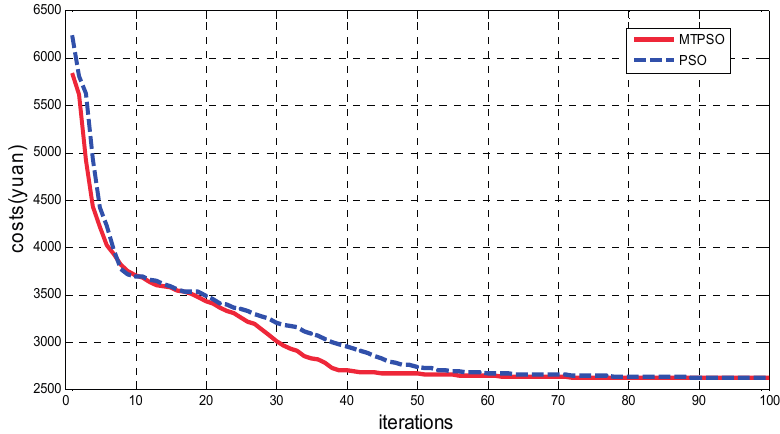
Figure 6. Convergence characteristics of PSO and multi-team PSO